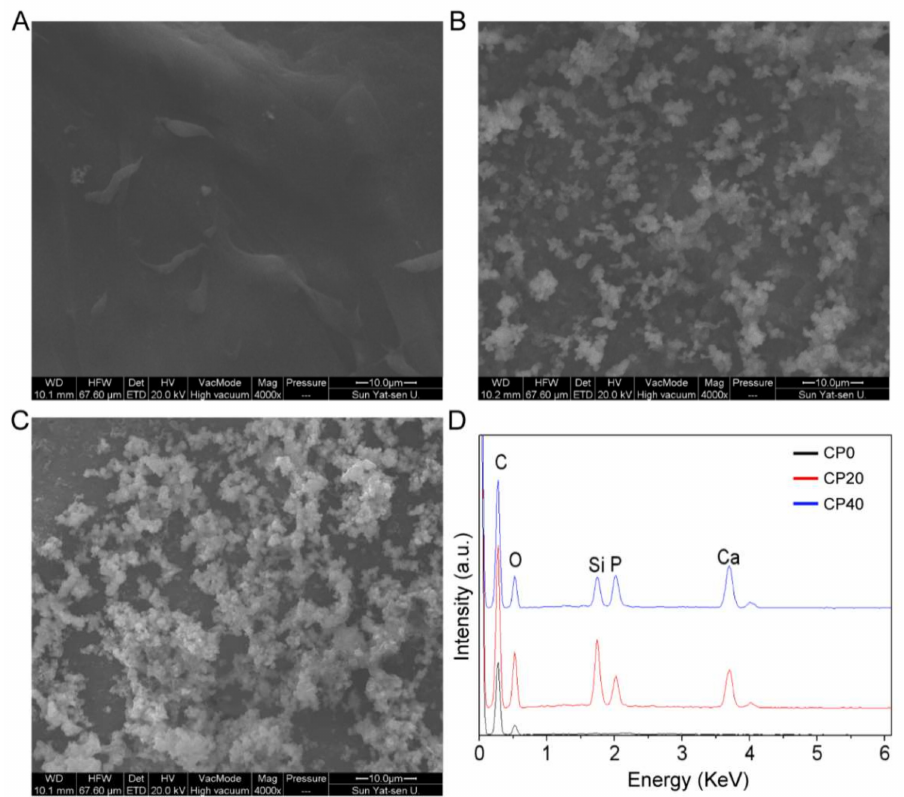
Figure 4. FESEM images of CP0 ( A ), CP20 ( B ), and CP40 ( C ) after immersion in SBF for 7 days, and EDS of scaffolds ( D ) after immersion.